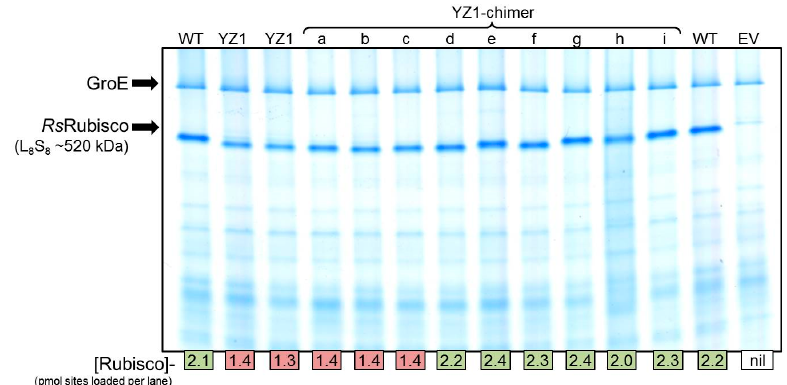
Figure 6. Native PAGE analysis of Rs Rubisco and the YZ1 chimers’ relative expression in JM109(DE3) after 0.5 mM IPTG induction for 6 h at 28 °C. The separated soluble cellular protein (4 μ g, including an empty vector (EV) JM109(DE3)-pET28a(+) control) was Coomassie stained, with the Rs Rubisco band intensity correlating with that quantified by 14 C-CABP binding (indicated at base of gel). Rs Rubisco biogenesis for the YZ1 chimers similar to wild-type (WT) are shaded green, while those produced in amounts equivalent to YZ1- Rs Rubisco are shaded